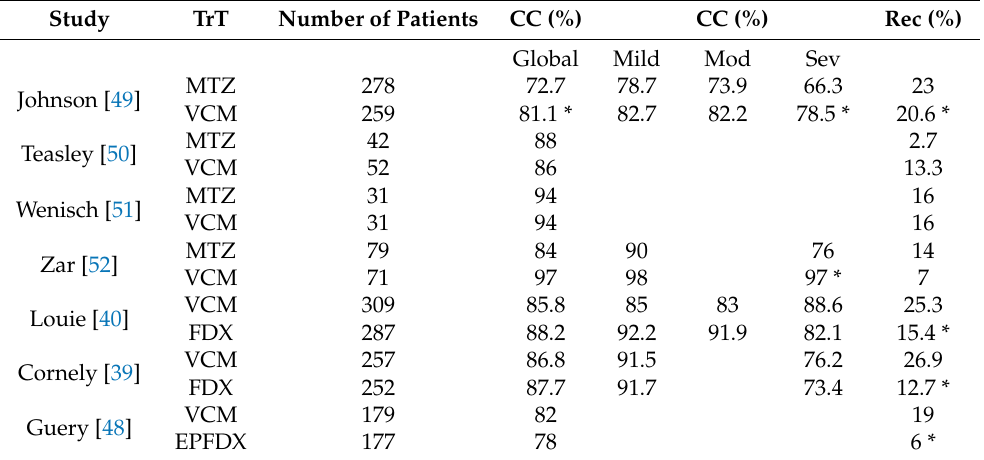
Table 2. Cure rate and sustained clinical cure rate with metronidazole, vancomycin and